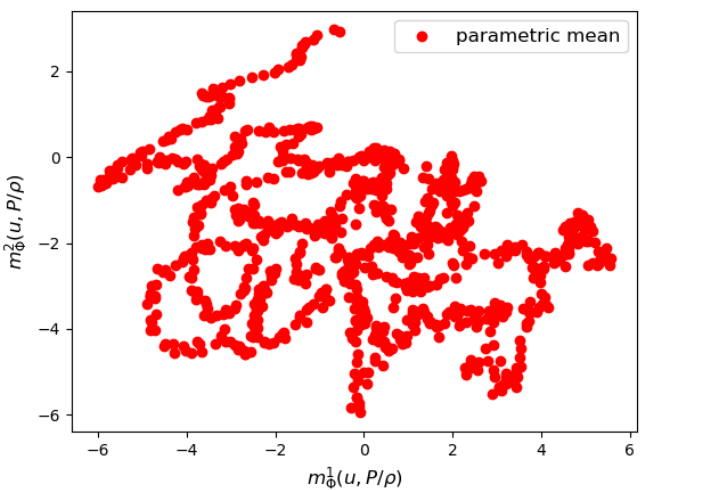
Figure 22. The first two components of the parametrized mean of the VAE encoder.